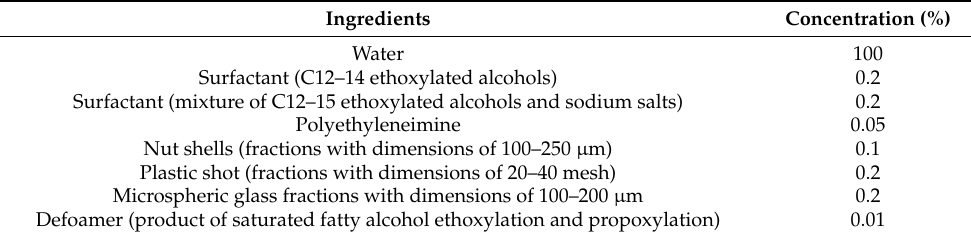
Table 1. Composition of the hybrid drilling washer fluid (Patent PL